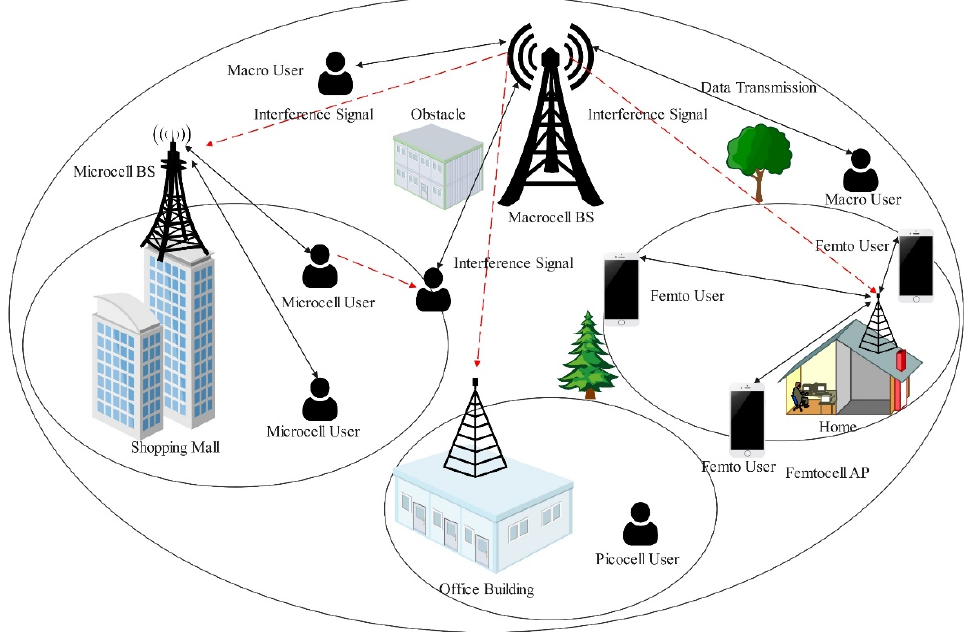
Figure 5. The two-tier HetNet with multiple SCs.